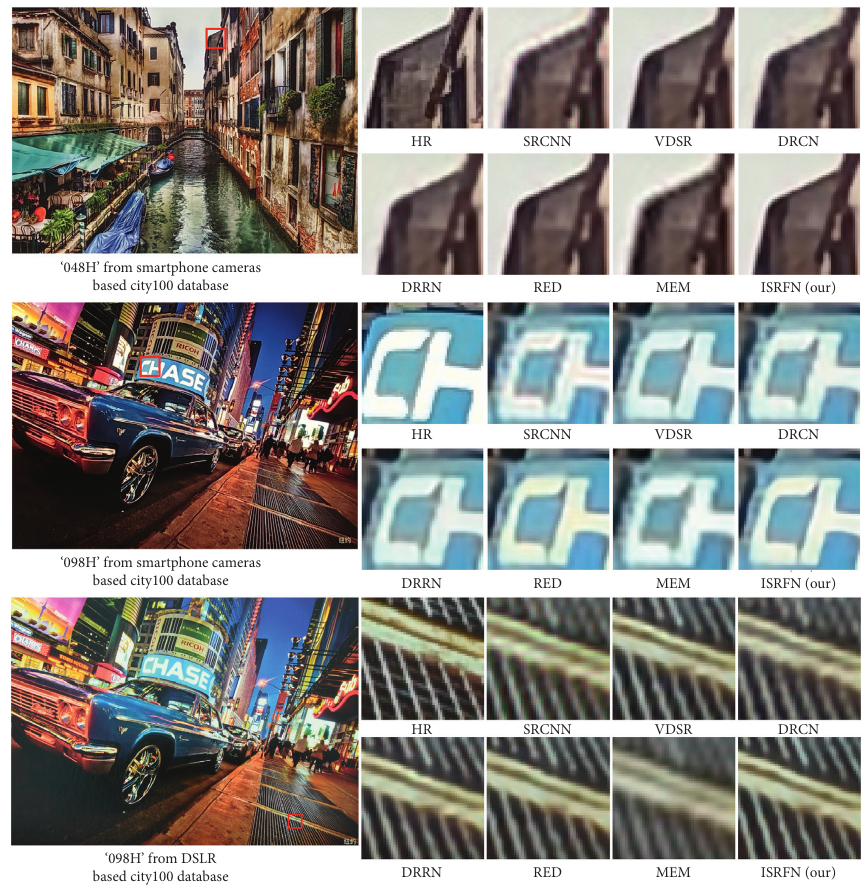
Figure 4: Visual comparison on smartphone cameras-based City100 database and DSLR-based City100